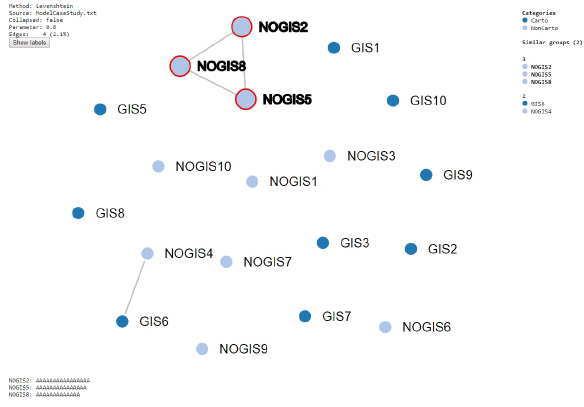
Figure 10. Output of ScanGraph showing two cliques based on parameter (cid:1868) (cid:3404) 0.8 .